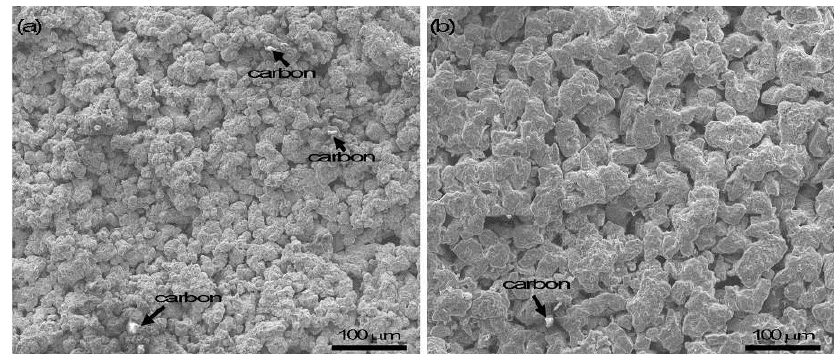
Figure 5. Surface morphologies of the small compacts sintered at 1250 ◦ C ( a ) and 1400 ◦ C ( b ), respectively. Sintering time was 4 h.